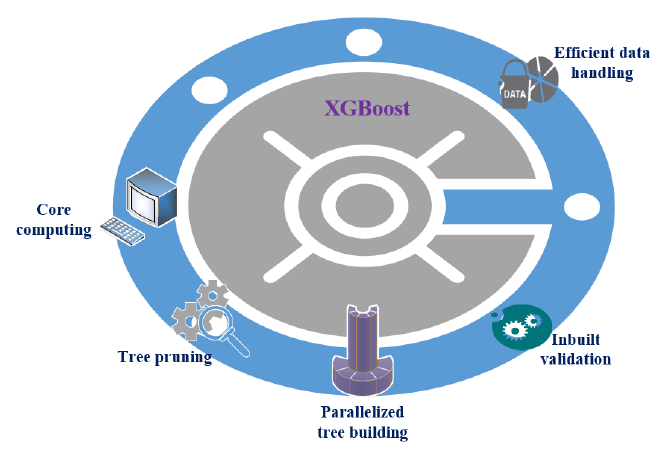
Figure 1. XGBoost. Figure 1.